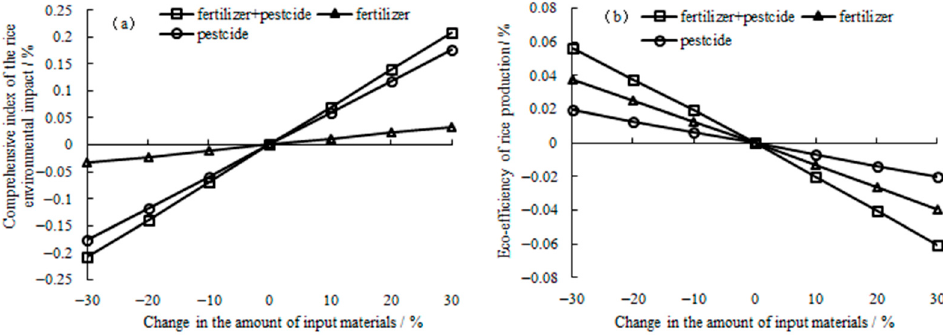
Figure 2. Sensitivity of the comprehensive environmental impacts ( a ) and eco-efficiency of the rice system ( b ).